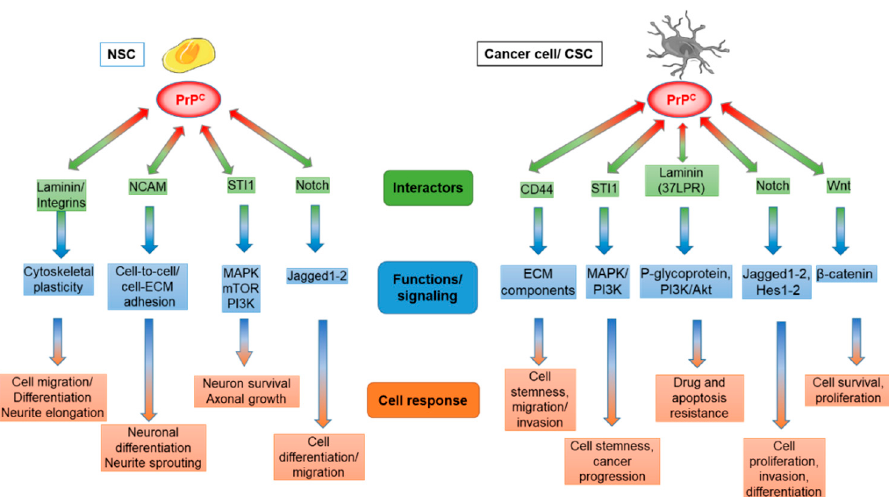
Figure 1. Comparison of cellular prion protein (PrP C ) engagement to multiple pathways in neural stem cells (NSCs), and cancer / cancer stem cells (CSCs). Partially overlapping interacting proteins between NSCs and CSCs were reported, although the interaction can determine di ff erent cell responses (orange in the figure). Abbreviations: NCAM: neural cell adhesion molecule; STI1: stress-inducible protein 1; 37LPR: 37-kDa laminin receptor; ECM: extracellular matrix; MAPK: mitogen-activated protein kinase; PI3K: phosphatidylinositol-3-Kinase; mTOR: mammalian target of rapamycin; Wnt: Wingless-related integration site family; Akt: Protein Kinase B; Hes1–2: hairy and enhancer of split 1–2.